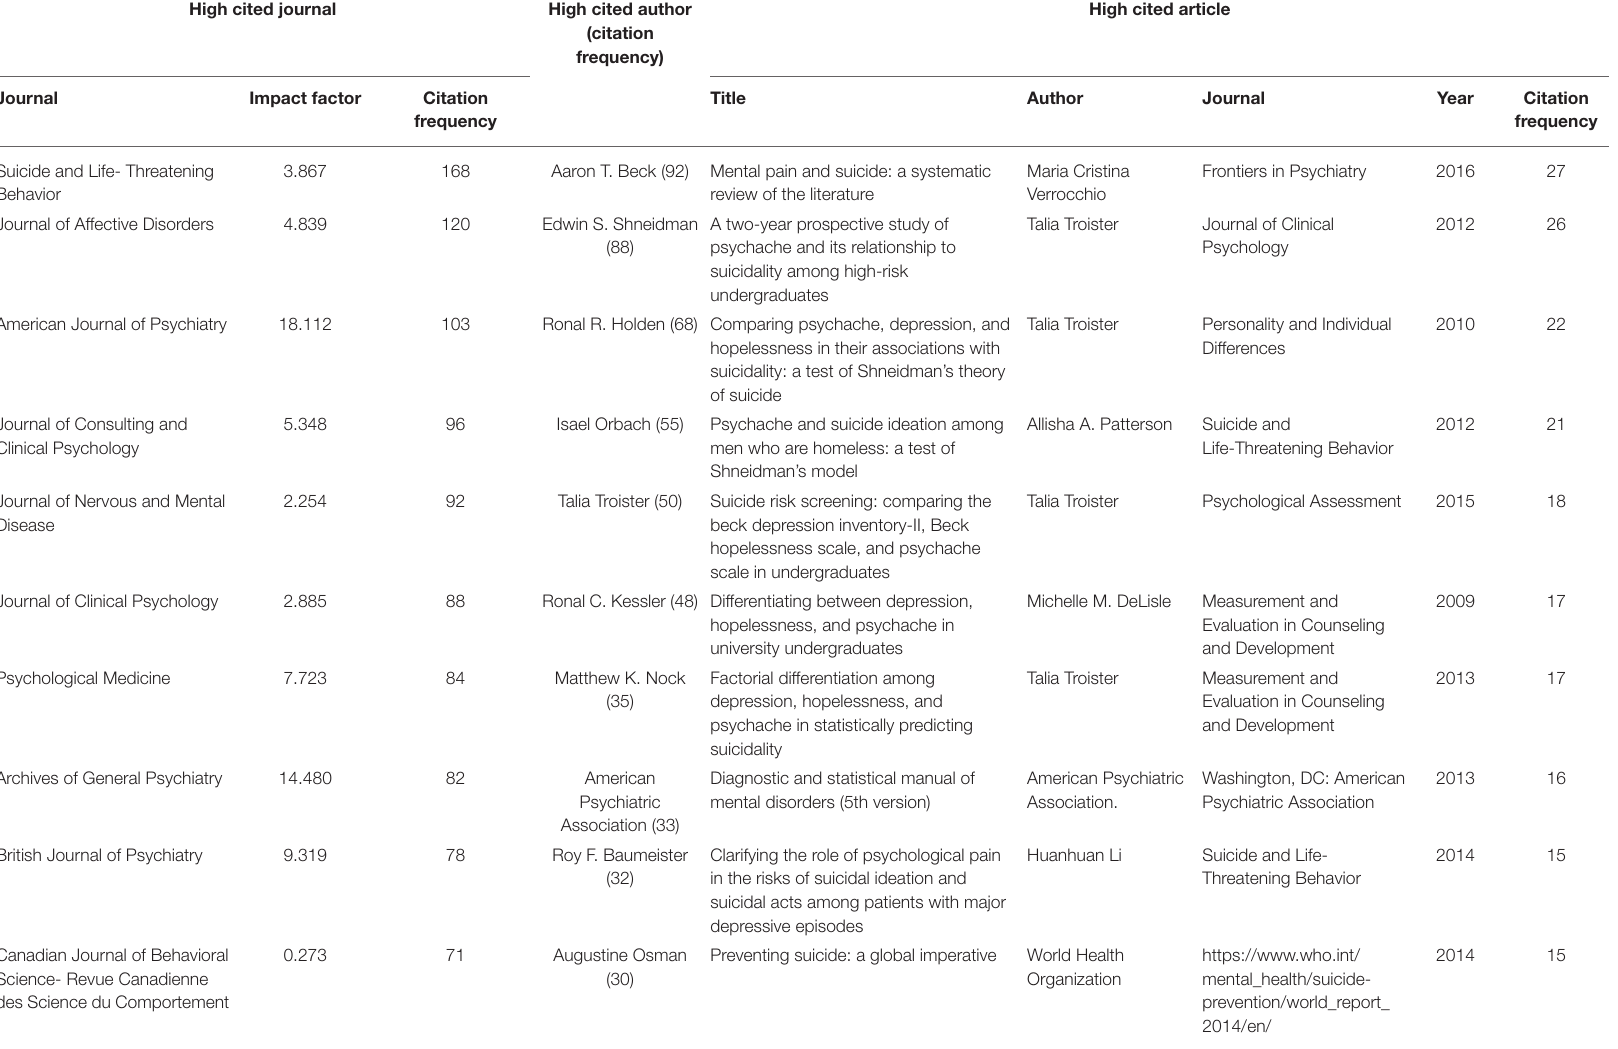
TABLE 3 | The top 10 journals, authors, and articles in terms of citation frequency during